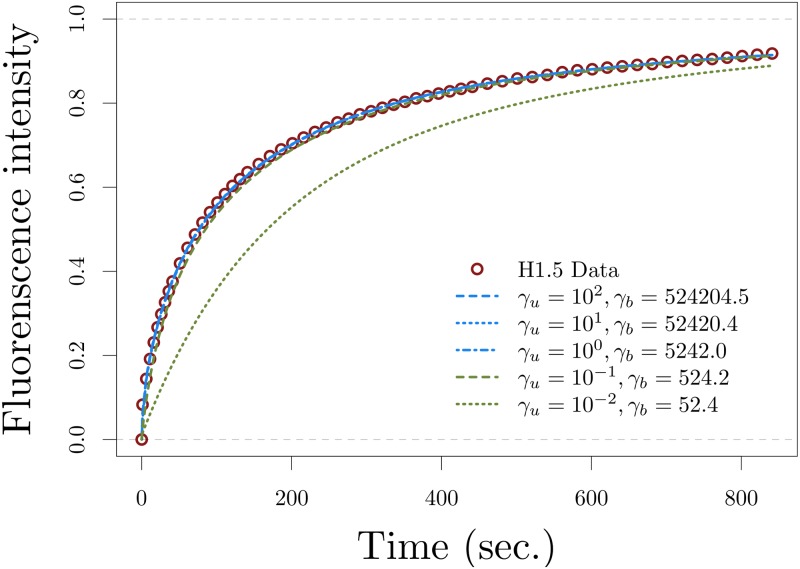
Recovery curves of the three population model 9 approximating H1.5 data for several parameter estimates with values greater than two orders of magnitude.The parameters values used for γ, ηb, and κu (8) are the ones obtained from fitting the leading-order approximation (4) to the data, the values for γu and γb = γγu vary across different orders of magnitude, and D = 25 μm2/s. Note that when the order of magnitude of γb is two (green dotted) or less, model 9 and its leading-order approximation are no longer equivalent.